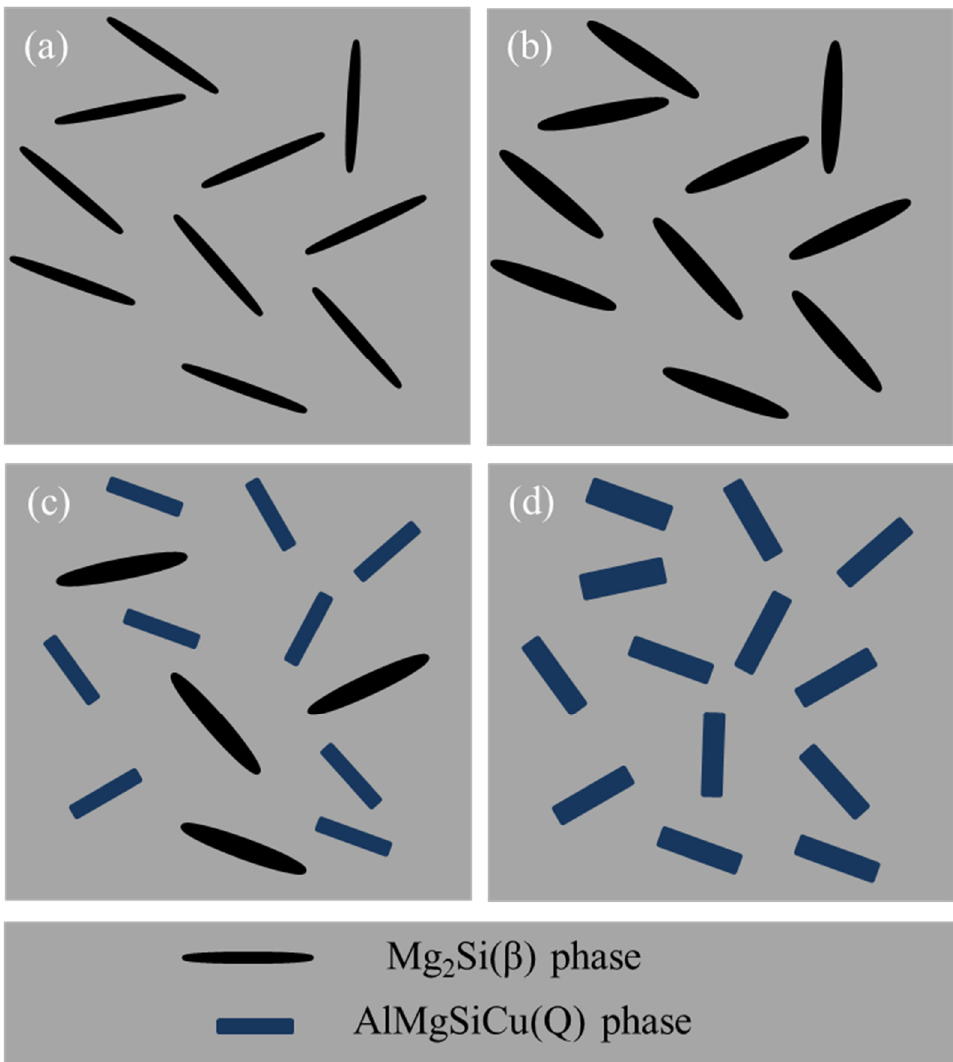
Figure 12. Evolution of the main precipitation strengthening phases of core alloy (6111) in differ- ent states. ( a – d ) correspond to the cold-rolled state, annealed state, brazed state, and aged state, respectively.